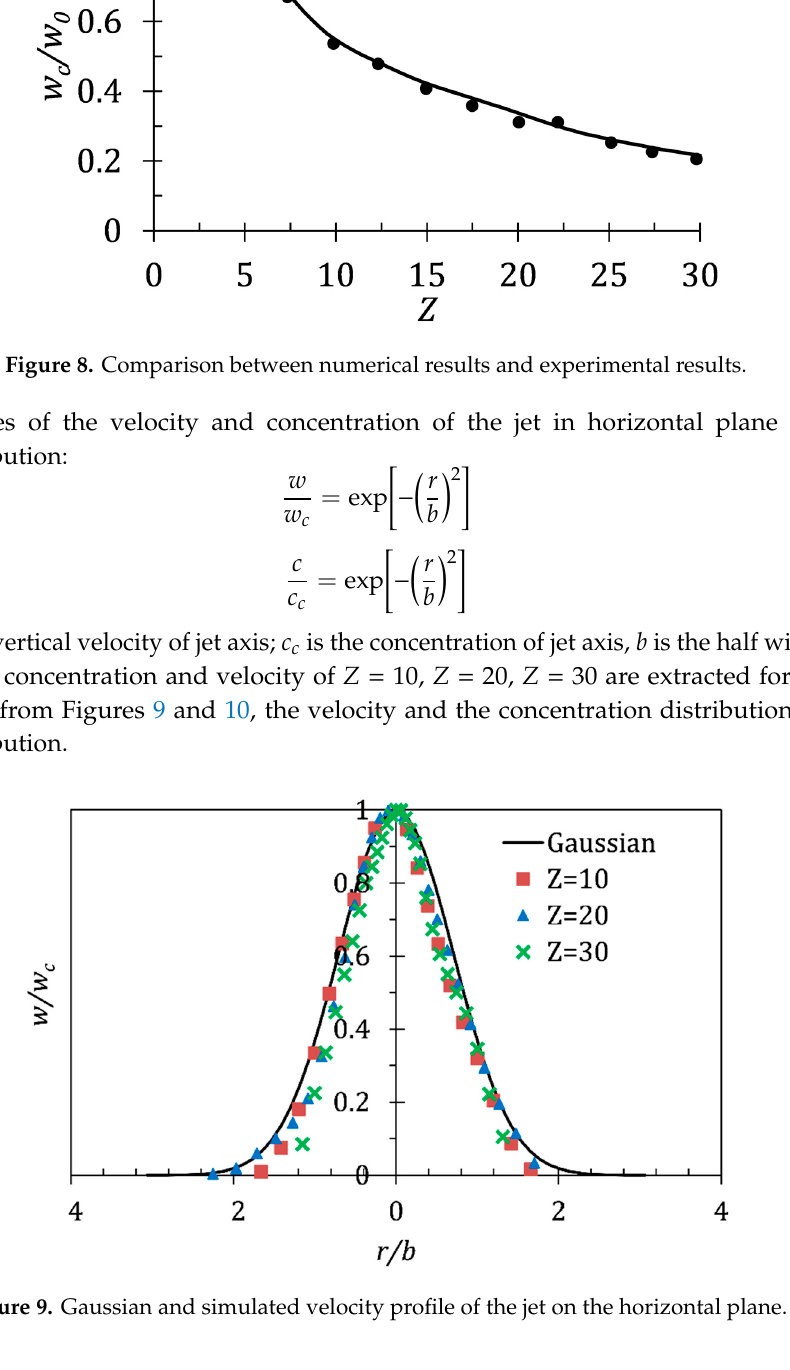
Figure 9. Gaussian and simulated velocity profile of the jet on the horizontal plane.